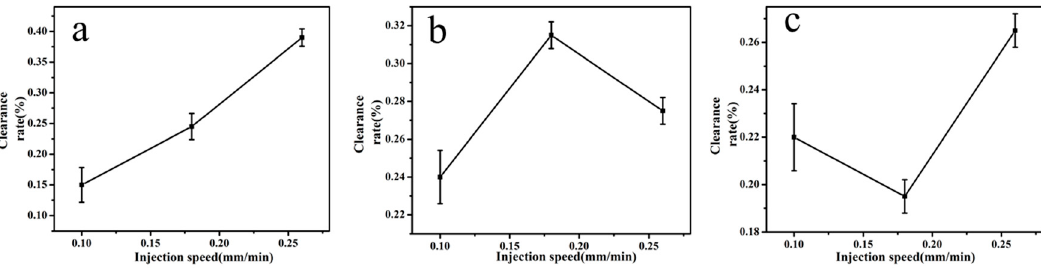
Figure 4. Impact of injection speed on the clearance rate of active molecular membranes ( a : quercetin; b : glycyrrhizic; c : α -mangostin). Table 5. The impact of the injection speed on the fiber diameter.